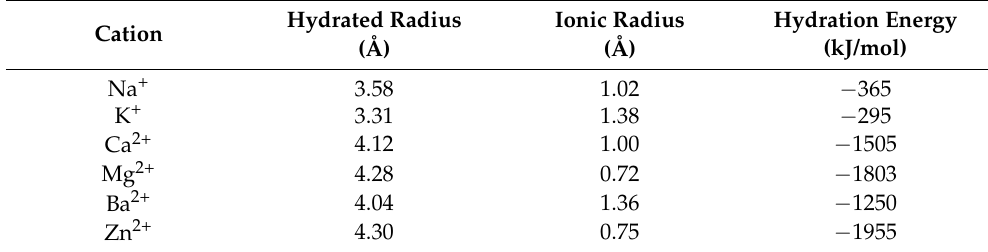
Table 5. Radii of hydration shells, ionic radii, and hydration energies for selected Me ions. The hydrated radius was obtained from [63]; the ionic radius and the hydration energies were obtained from [64].